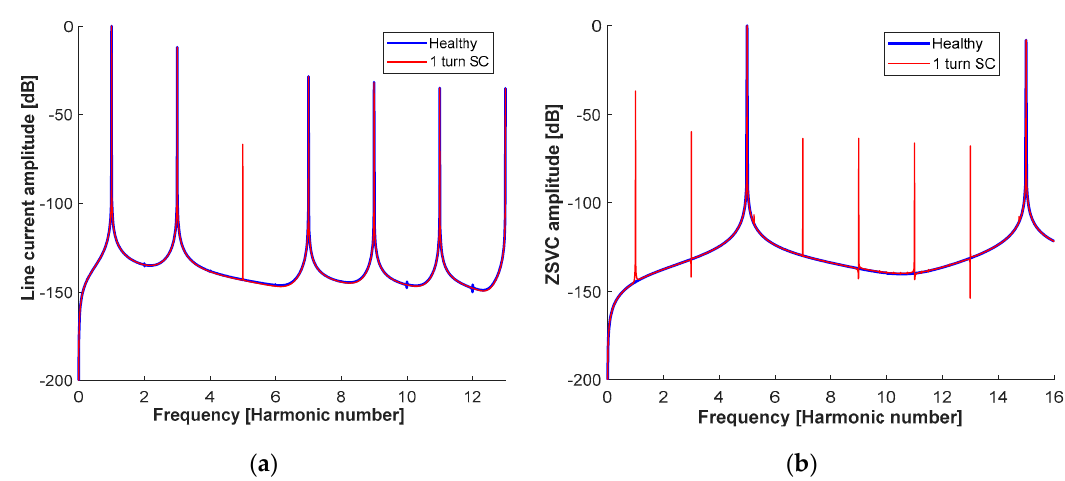
Figure 5. Harmonic frequencies of the fPMa-SynRM operating at low-saturation conditions. Comparison between healthy and faulty conditions (one shorted turn). ( a ) Line current harmonics of the faulty phase. ( b ) ZSVC harmonic frequencies.